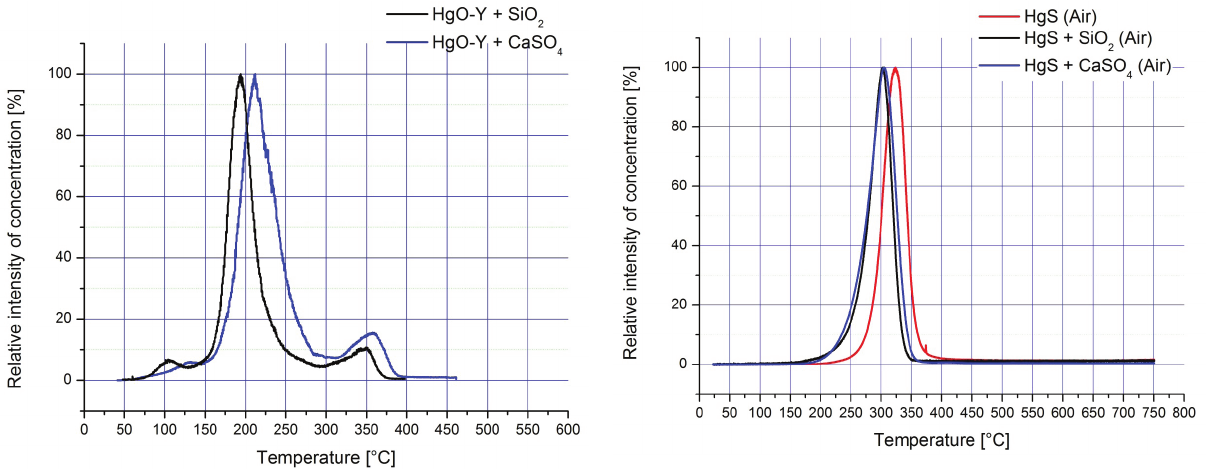
Figure 14: Thermograms of HgS, purged with nitrogen.